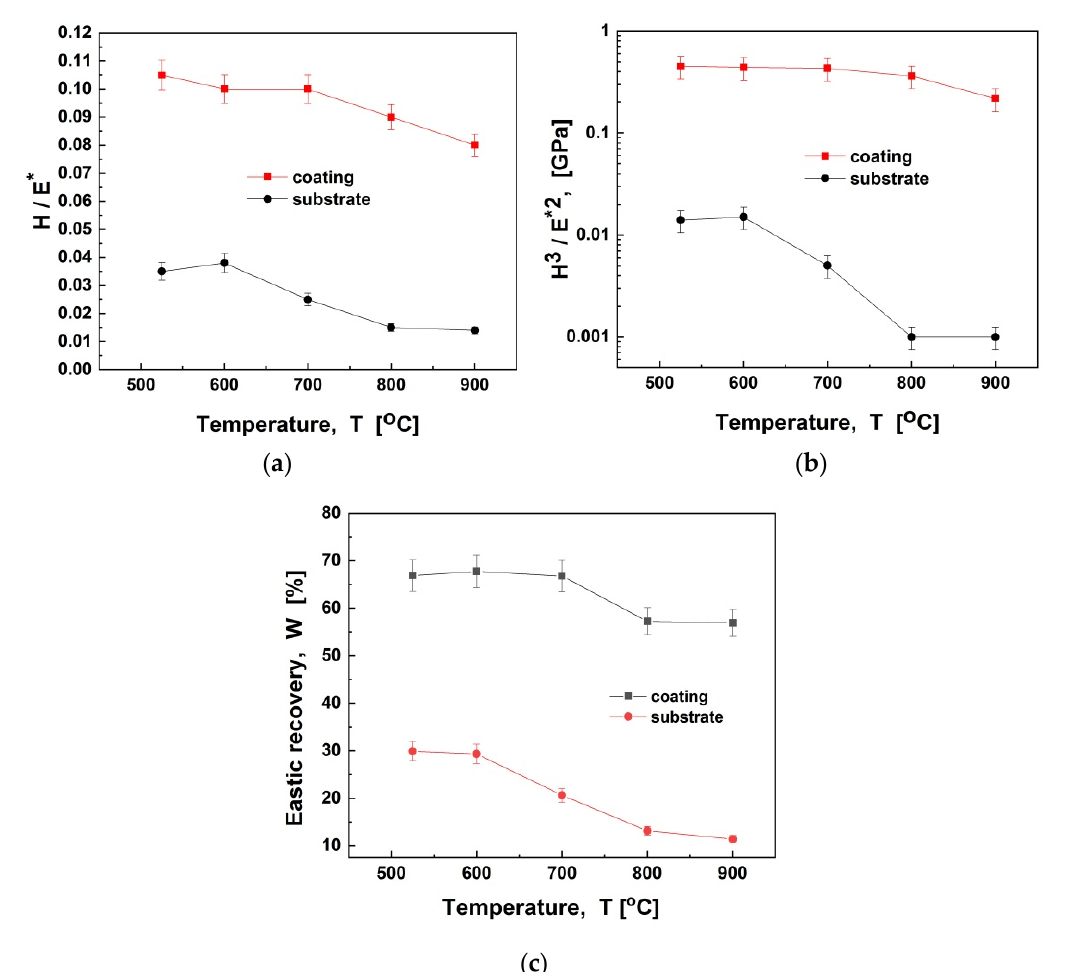
Figure 2. Temperature dependence of elastic strain to failure ( a ), resistance to plastic deformation ( b ), and elastic recovery ( c ) of modulated CrAlSiN-AlSiN coating and substrate.